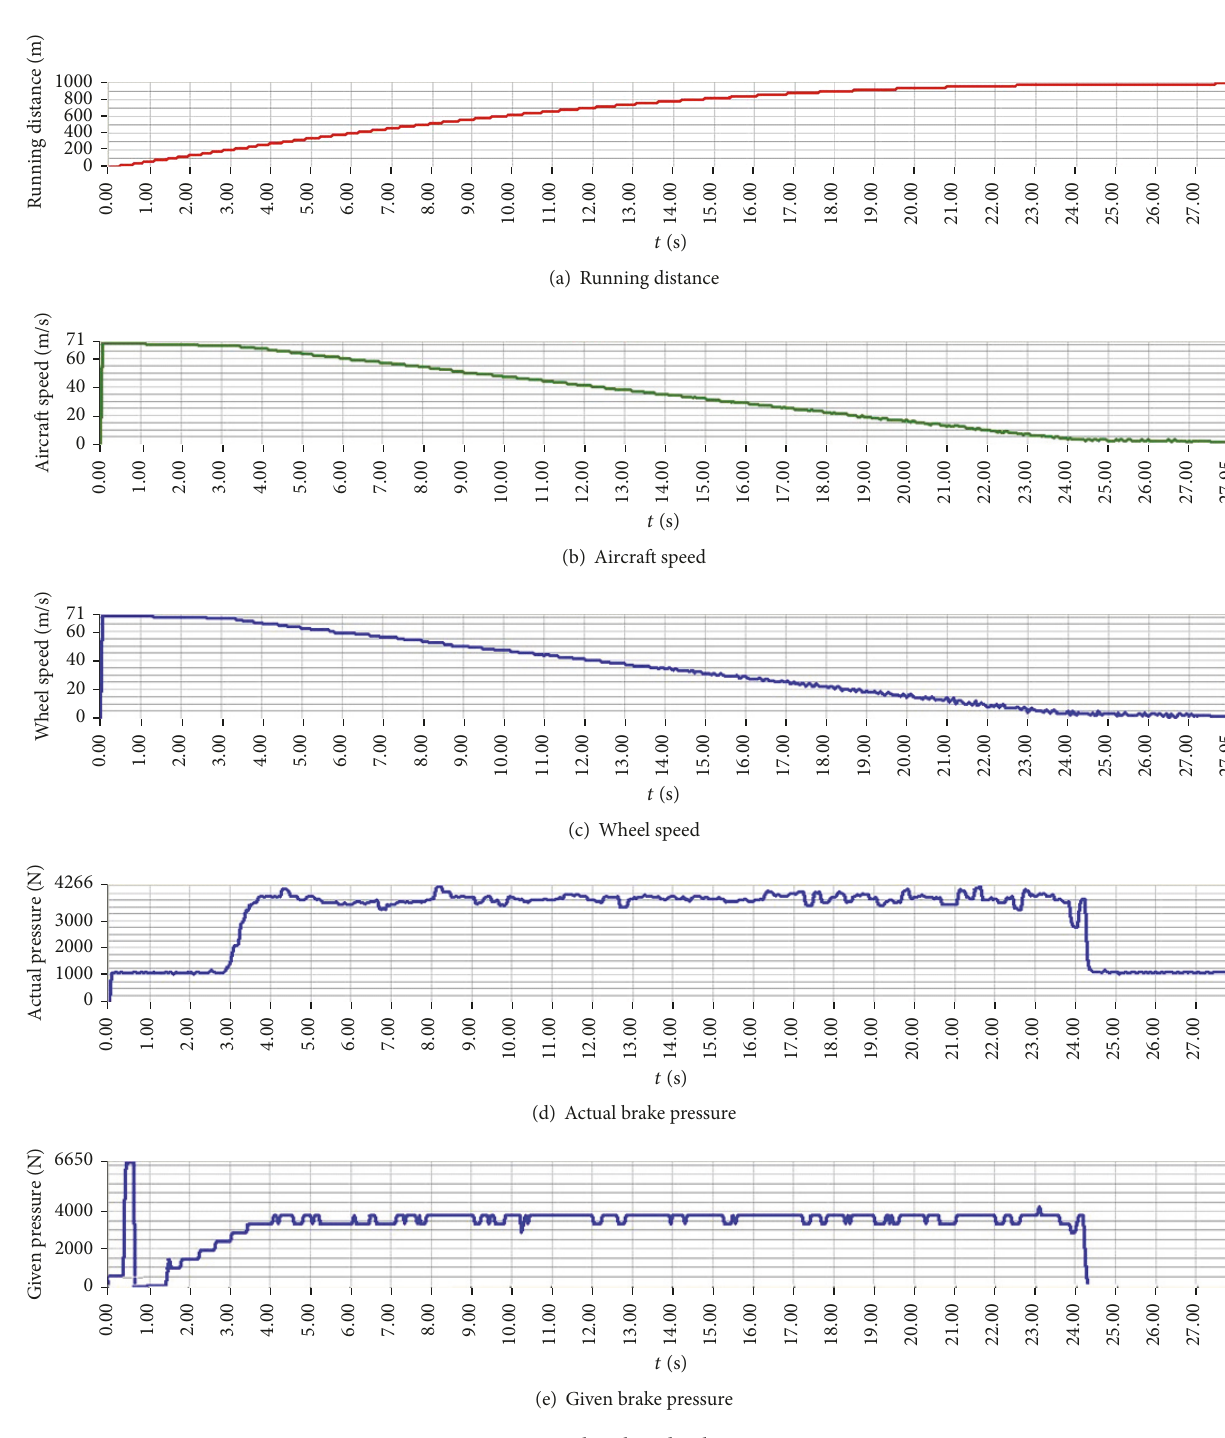
Figure 14: HILS results when deceleration rate is